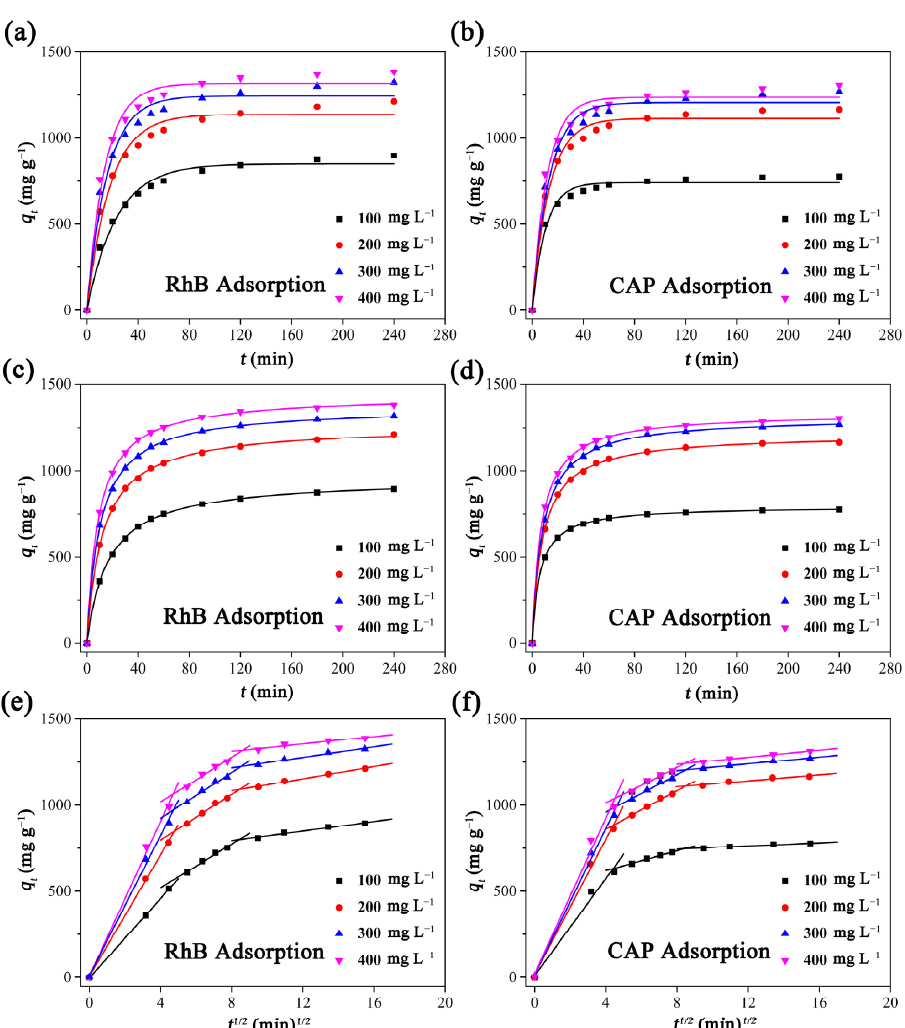
Figure 5. The ( a , b ) nonlinear pseudo-first order, ( c , d ) pseudo-second order, and ( e , f ) intra-particle diffusion kinetic models for the adsorption of PCAC toward RhB and CAP, respectively. Condi- tions: adsorbent, 20 mg; solution volume, 200 mL; initial concentration, 100–400 mg L − 1 ; temperature, 30 °C. The pH values of solutions were not adjusted.